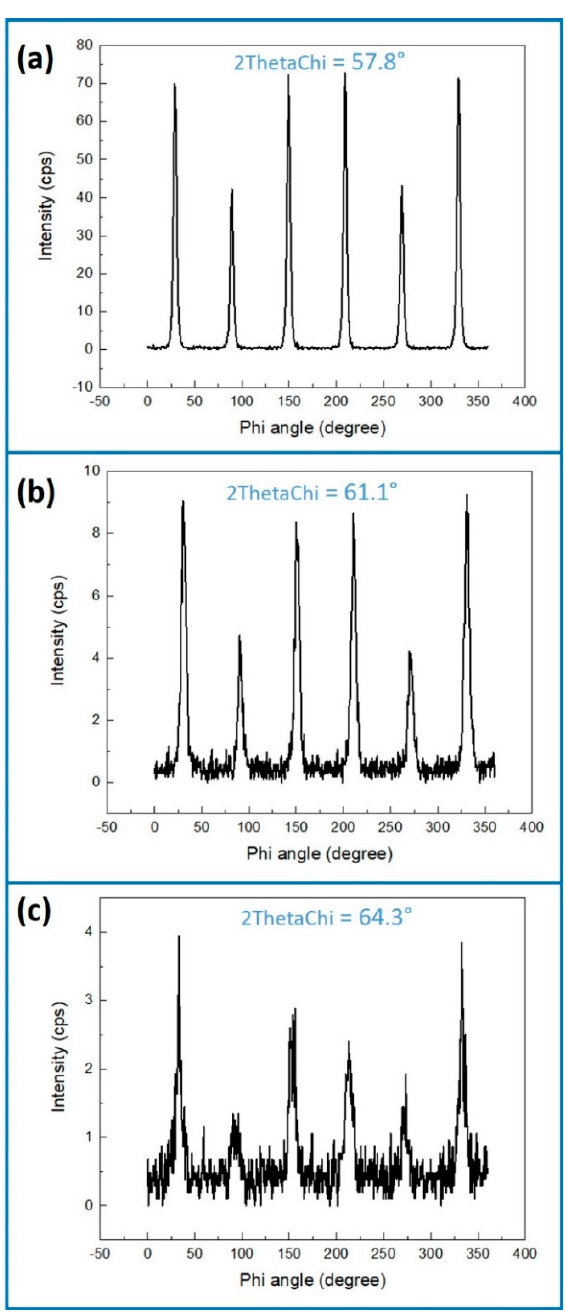
Figure 5. XRD analyses using in-plane Phi scan configuration of GaN / β -Ga 2 O 3 NWs with the detector (2ThetaChi) fixed at 57.8 ◦ ( a ), 61.1 ◦ ( b ) and 64.3 ◦ ( c ) corresponding respectively to GaN (11-20), β -Ga 2 O 3 (020) and β -Ga 2 O 3 (403) peak positions.